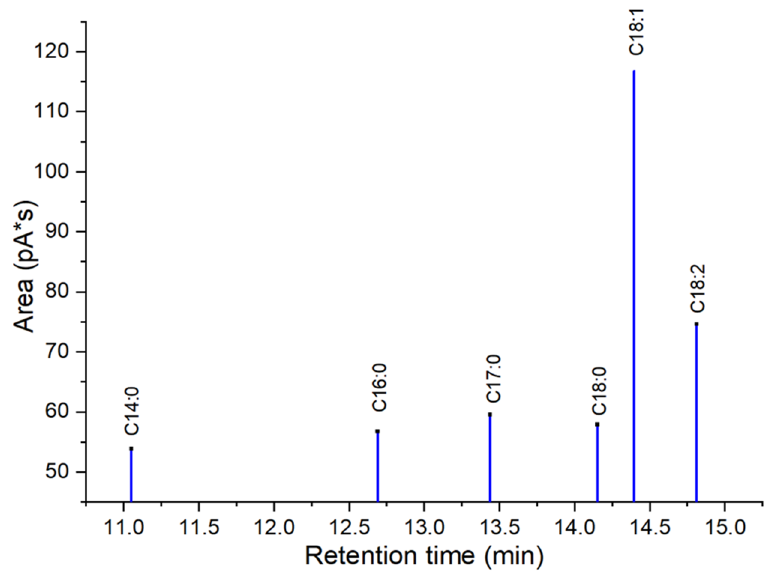
Figure 11. Chromatogram of methyl esters standard; C14:0 = methyl myristate, C16:0 = methyl palmitate, C17:0 = methyl heptadecanoate (internal standard), C18:0 = methyl stearate, C18:1 = methyl oleate, C18:2 = methyl linoleate.